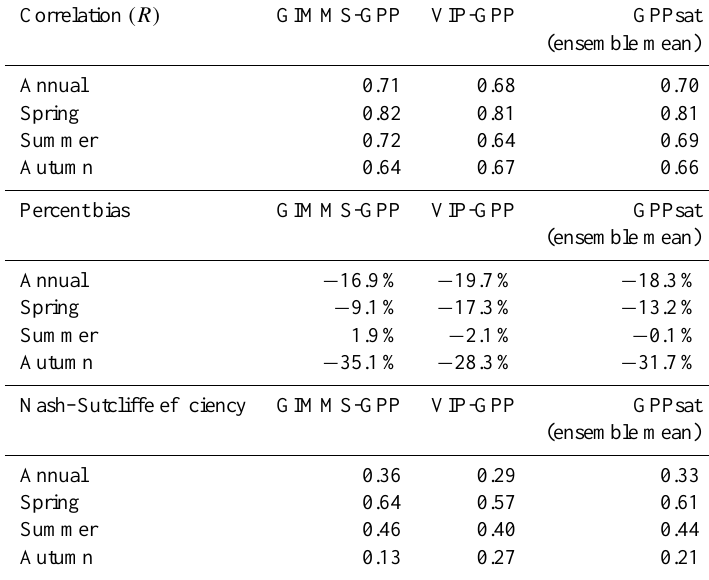
Table 3. Validation of GIMMS3g and VIP-GPP data sets along with their ensemble mean using flux tower GPP from 10 flux tower sites across northern Eurasia. The spatial distribution of the flux tower sites is shown in Fig. 1. Validation was carried out using the following approaches. (1) Pearson’s product moment correlation, which is a measure of the linear dependence between the simulated and observed GPP and its value ranges from − 1 to + 1, where 0 is no correlation and − 1 / + 1 is total negative or positive correlation. (2) Percent bias, which measures the average tendency of the simulated values to be larger or smaller than their observed ones. The optimal value is 0.0, with low-magnitude values indicating accurate model simulations. Positive values indicate overestimations and vice versa (Yapo et al., 1996; Sorooshian et al., 1993). (3) Nash–Sutcliffe model efficiency coefficient (Nash and Sutcliffe, 1970), values of which range from −∞ to 1. An efficiency of 1 corresponds to a perfect match of model-simulated GPP to the observed data. An efficiency of 0 indicates that the model predictions are as accurate as the mean of the observed data, whereas an efficiency less than zero occurs when the observed mean is a better predictor than the model or, in other words, when the residual variance (between modelled and observed values) is larger than the data variance (between observed values and the observed mean). Essentially, the closer the model efficiency is to 1, the more accurate the model